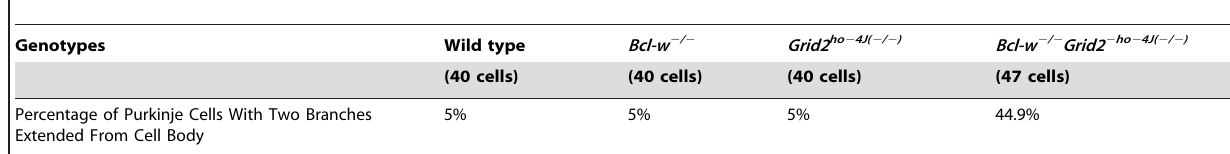
Table 3. Purkinje Cell Primary Dendrite Defect in Bcl-w 2 / 2 Grid2 ho 2 4J( 2 / 2 ) Mice.